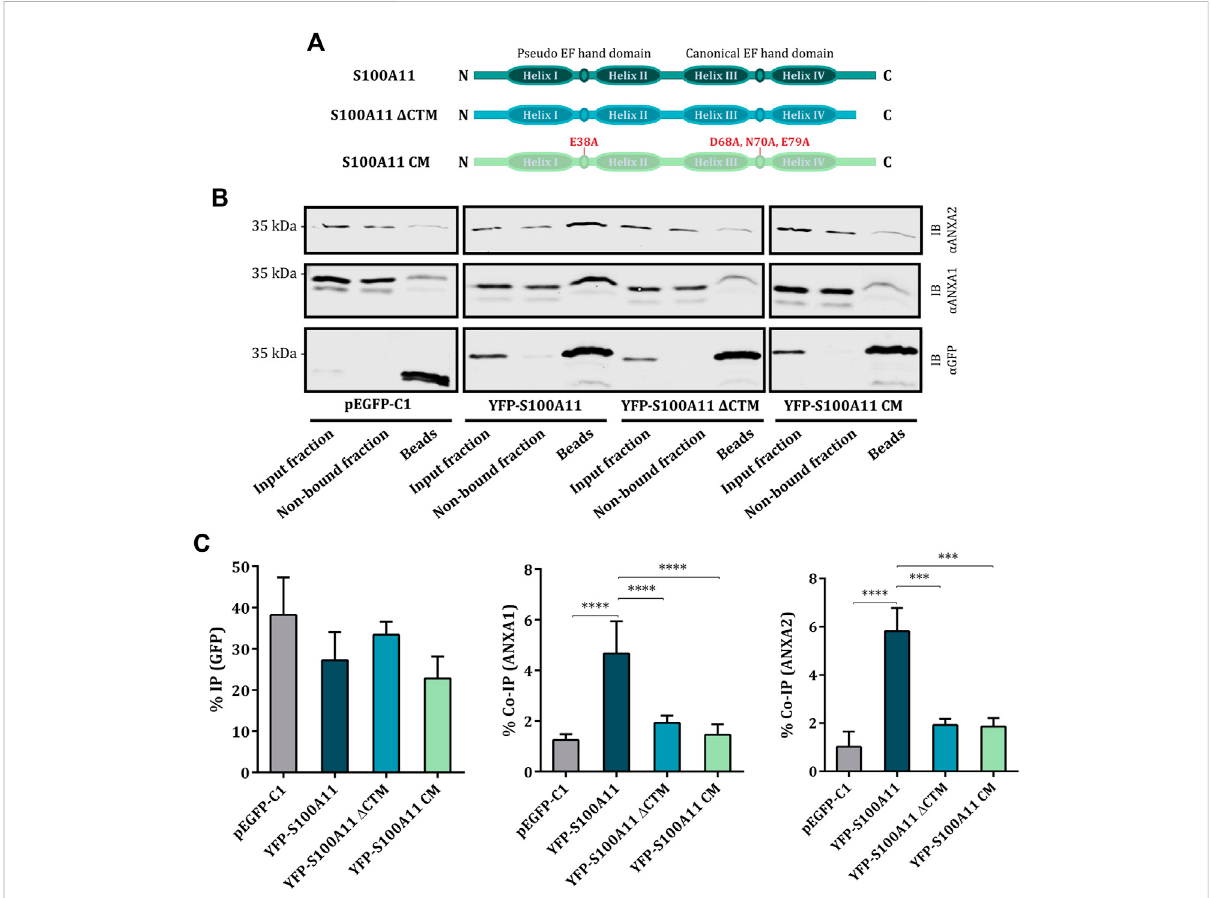
FIGURE 3 S100A11 interacts with ANXA1 and ANXA2 via its C-terminal extension at elevated Ca 2+ conditions. (A) Domain structures of wild type S100A11, S100A11 Δ CTMandS100A11CM.TheschemeshowsN-terminusontheleftandC-terminusontheright. (B) Representativeimmunoblotsofsamples (input fraction, non-bound fraction and immunoprecipitates/beads) from S100A11-KO cells transfected with empty GFP vector, YFP-S100A11, YFP- S100A11 Δ CTM or YFP-S100A11 CM. Lysates of the respective cells were subjected to IP reactions in the presence of 2 mM Ca 2+ . Immunoblots were probed with anti-GFP antibodies to detect GFP alone (27 kDa) and YFP-S100A11, YFP-S100A11 Δ CTM or YFP-S100A11 CM (~39 kDa), respectively, and with anti-ANXA1 (39 kDa) or anti-ANXA2 (38 kDa) antibodies to detect co-immunoprecipitated endogenous